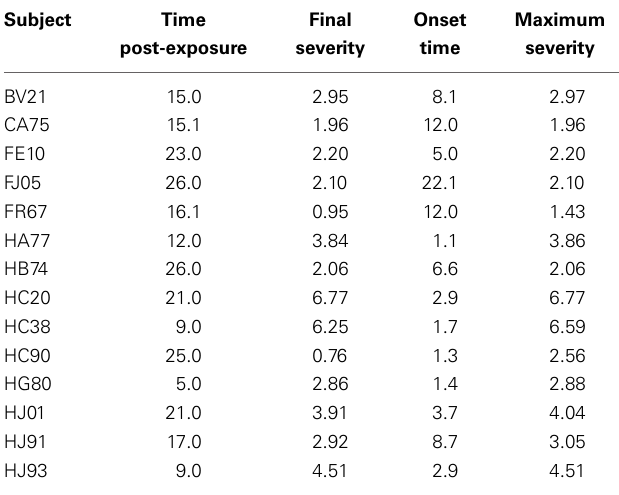
Table 2 | Features of fitted disease trajectories.